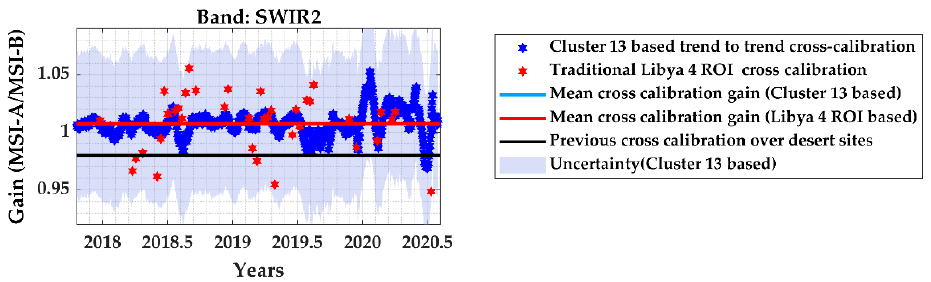
Figure 20. Comparison of Sentinel 2A and Sentinel 2B MSI cross-calibration gain ratio with cluster- and PICS-based approach.